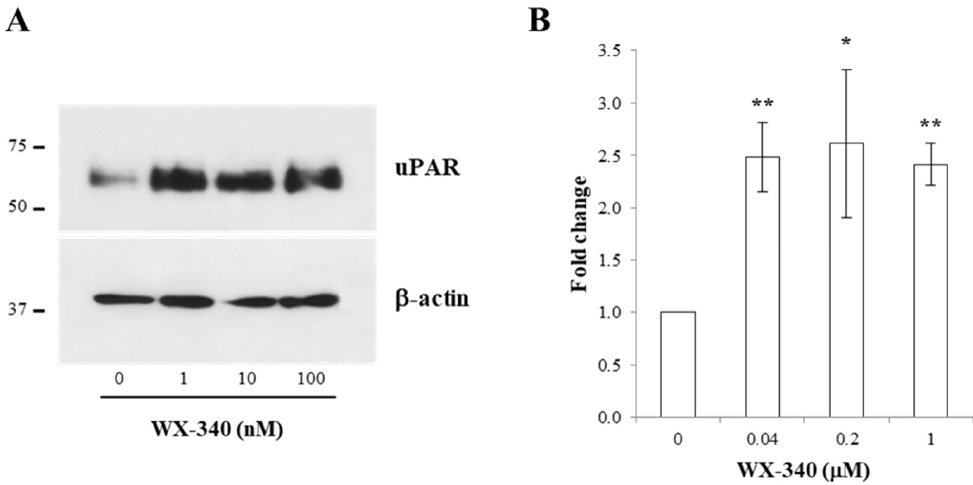
Figure 5. ( A ) Representative Western blotting experiment with BHT-101 treated with increasing doses of WX-340; ( B ) densitometric analysis of the immunoblotted bands. * p < 0.05; ** p < 0.01. However, a concomitant increase in the share of membrane uPAR, measured by citofluorimetric analysis, was not observed even at 5 µ M (Figure 6).